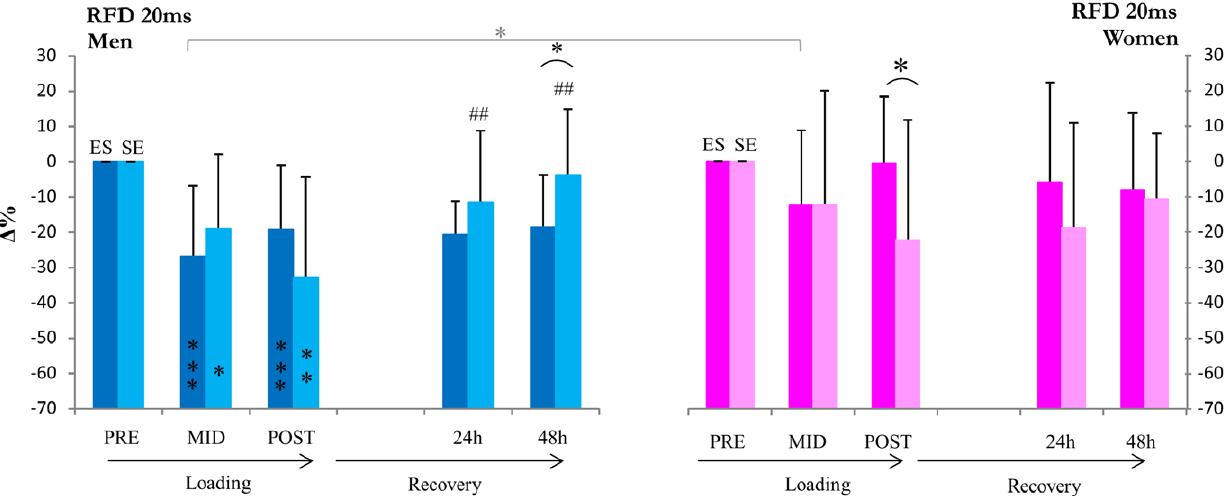
Figure 2. Isometric rate of force development. *, **, *** inside column=significant change (p , 0.05, p , 0.01, p , 0.001) in absolute rate of force development from pre, ## =significant change (p , 0.01) in absolute rate of force development from post. *[=significant difference (p , 0.05) between changes in RFD from pre in men and women. *(=significant difference (p , 0.05) between relative changes from pre in ES and SE loadings.